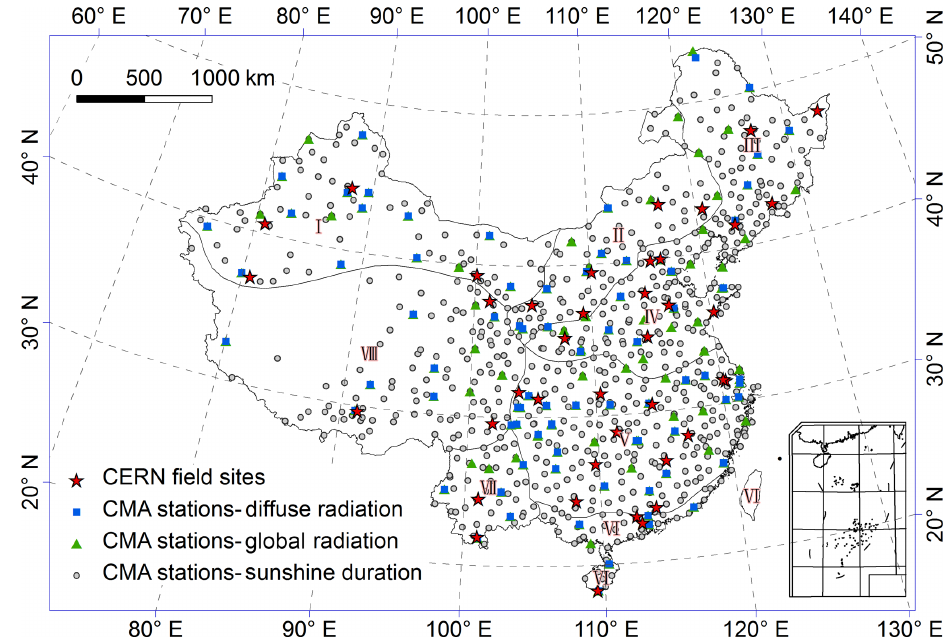
Figure 2. Distribution of the meteorological stations of the China Meteorology Administration (CMA) that measured sunshine duration, global radiation, and diffuse radiation, and the field sites of the Chinese Ecosystem Research Network (CERN) that measured global radiation and PAR (I: Northwest China; II: Inner Mongolia; III: Northeast China; IV: North China; V: Central China; VI: South China; VII: Southwest China; VIII: Qinghai–Tibet Plateau).